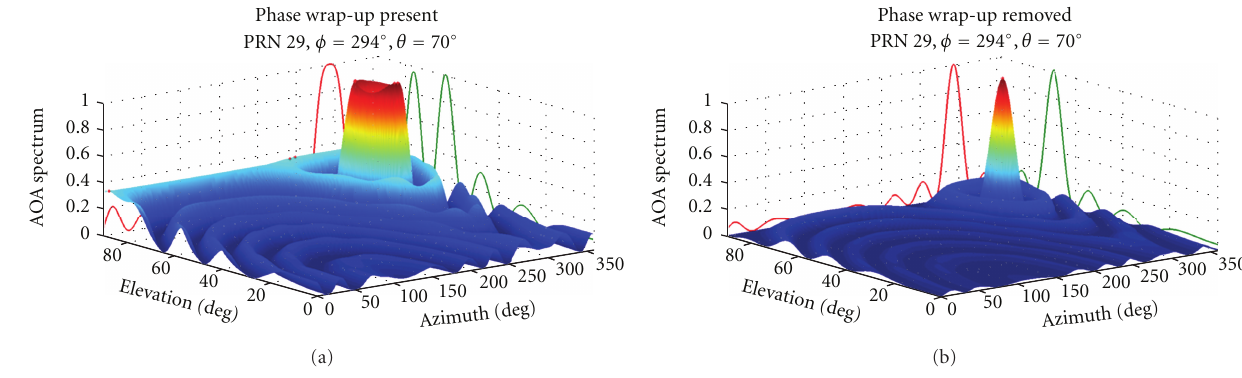
Figure 5: Data collection locations, equipment, and layout.